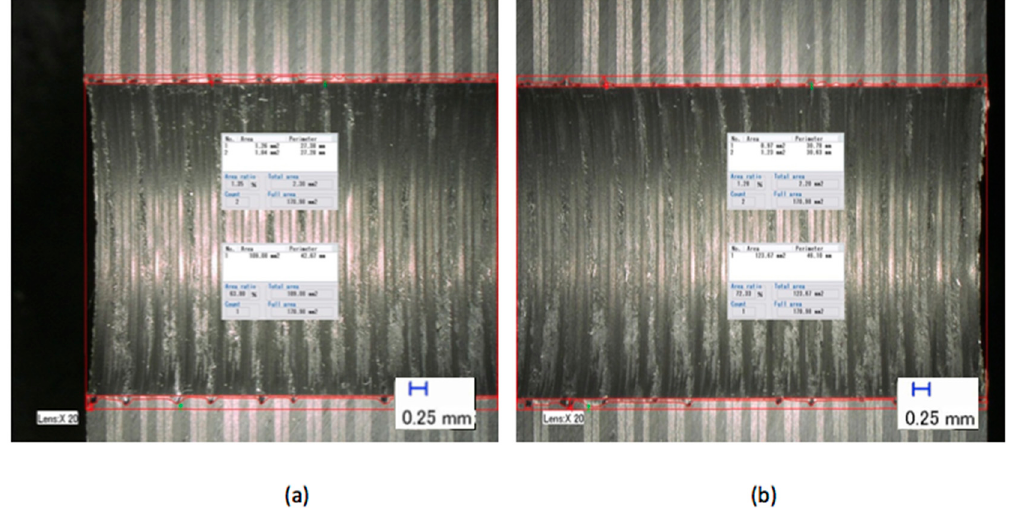
Figure 7. Typical example of cross-section measurement for the extension of adjusted delamination factor (S FDSR ) at a feed rate of 0.3 mm/rev and a cutting speed of 64 m/min: ( a ) bottom part; ( b ) top part.